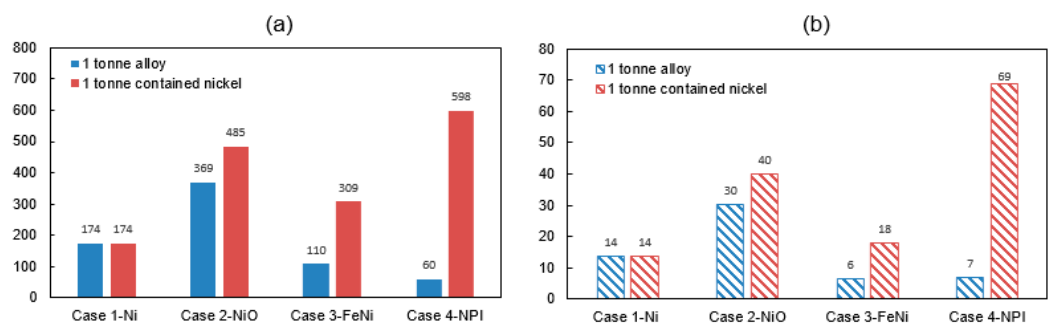
Figure 5. ( a ) Energy consumption (GJ / t alloy) and ( b ) GHG emissions (tCO 2 -eq / t alloy) on the basis of one tonne contained nickel.